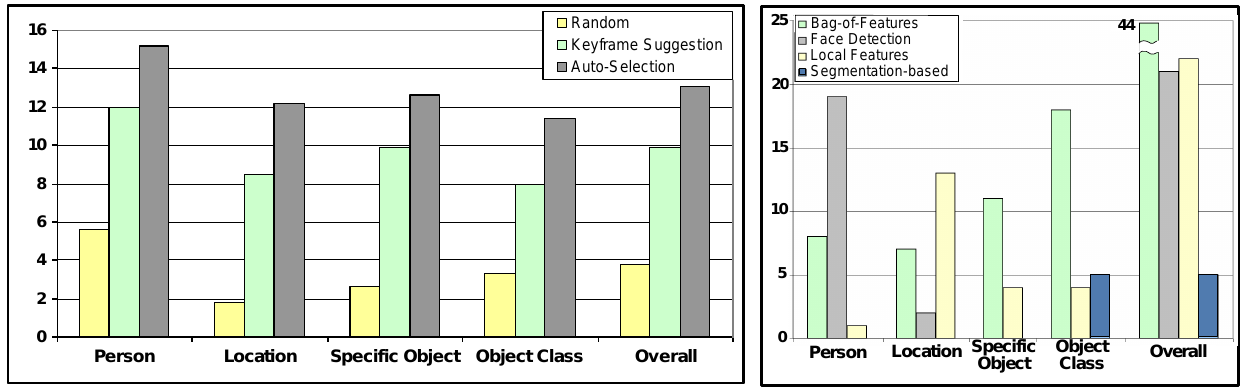
Figure 11. Correct keyframes (left) and selected approaches (right) per object